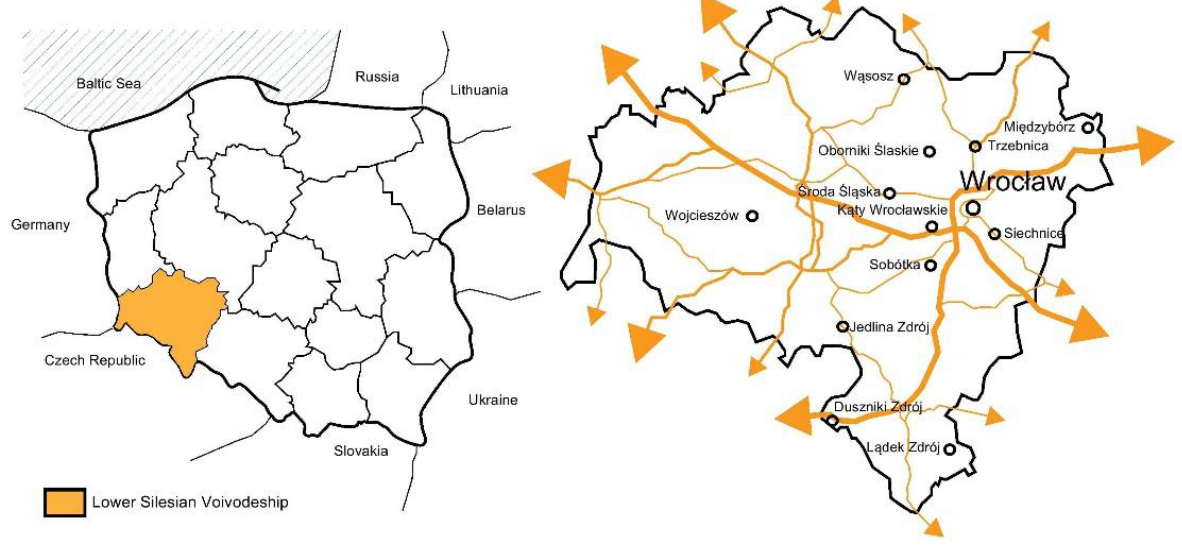
Figure 2. Dolno´sl ˛askie Voivodeship located in southern Poland. Analysed Figure 2. Dolnośląskie Voivodeship located in southern Poland. Analysed towns.